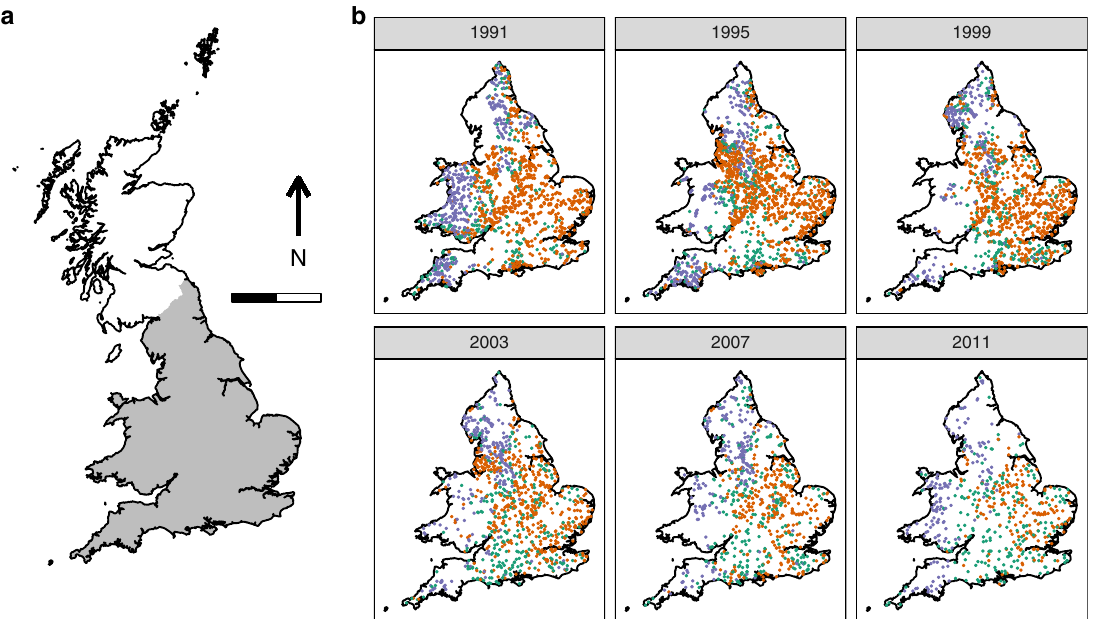
Fig. 3 The study area and locations of macroinvertebrate samples collected for calculating transition probabilities among years. a Outline of Great Britain, indicating England and Wales (shaded): the scale bar is 200 km. b The samples collected in each year (sample sizes are given in Supplementary Table 1), shaded according the biological class to which they belonged. The colour scheme matches Fig. 1. For brevity, data are shown for four-year intervals (see Supplementary Fig. 2 for a full version). National outlines contain OS data © Crown copyright and database right